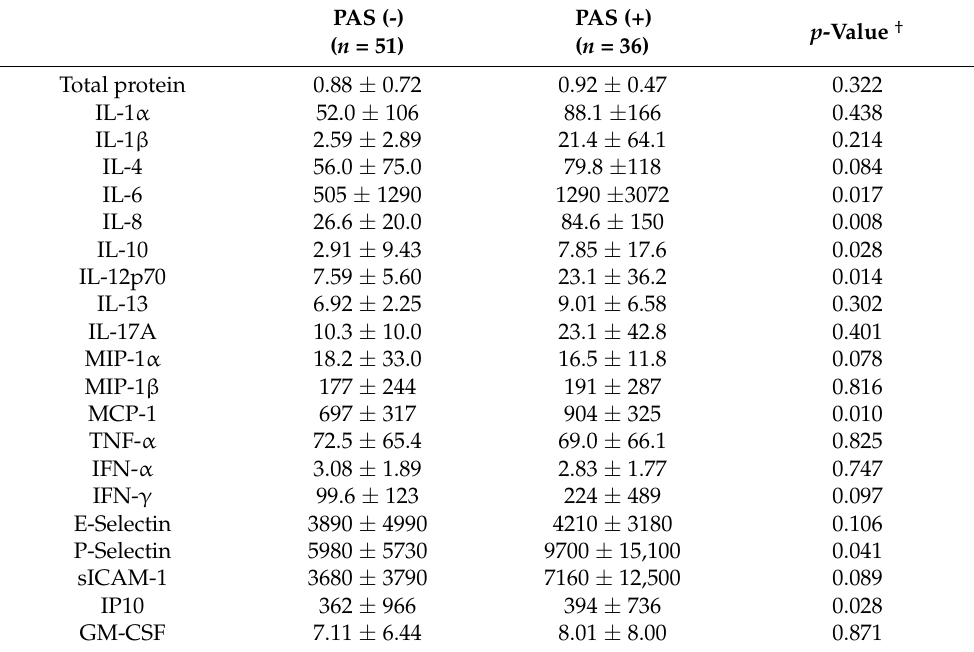
Table 3. Preoperative aqueous cytokine levels stratified by the presence of PAS after PKP.